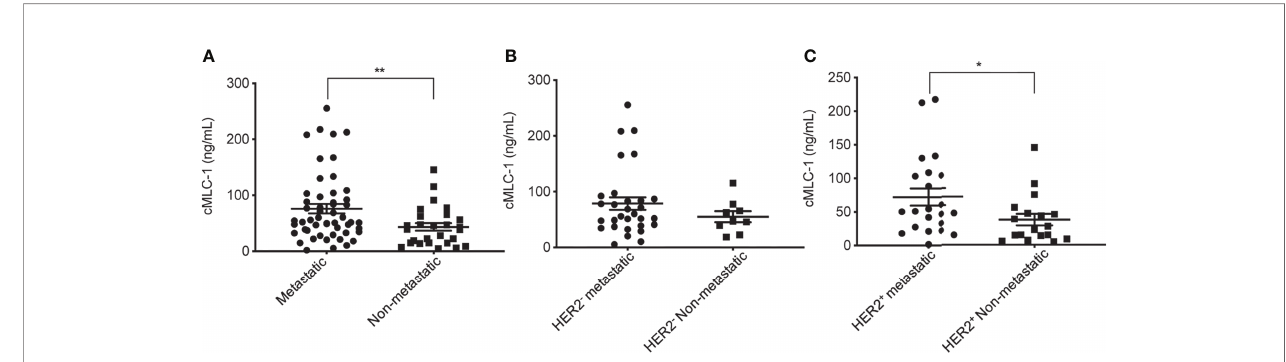
FIGURE 4 | Plasma cMCL-1 was higher in metastatic than non-metastatic breast cancer patients. The means ± SD of cMLC-1 in metastatic (n=52) vs. non- metastatic patients (n=27) are shown (** p =0.0069) (A) . Plasma cMLC-1 was not signi fi cantly different in HER2 - metastatic (n=30) vs. non-metastatic patients (n=9) ( p =0.3657) (B) . Plasma cMLC-1 was higher in HER2 + metastatic (n=22) vs. non-metastatic patients (n=18) (* p =0.0204) (C) . The Mann-Whitney U test was used to analyze the above differences between every two